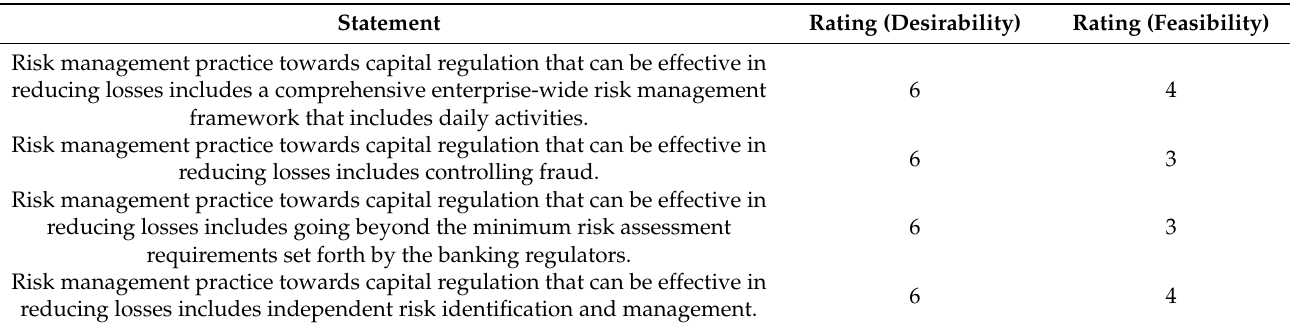
Table 3. Statements that Satisfied Consensus Threshold in Round